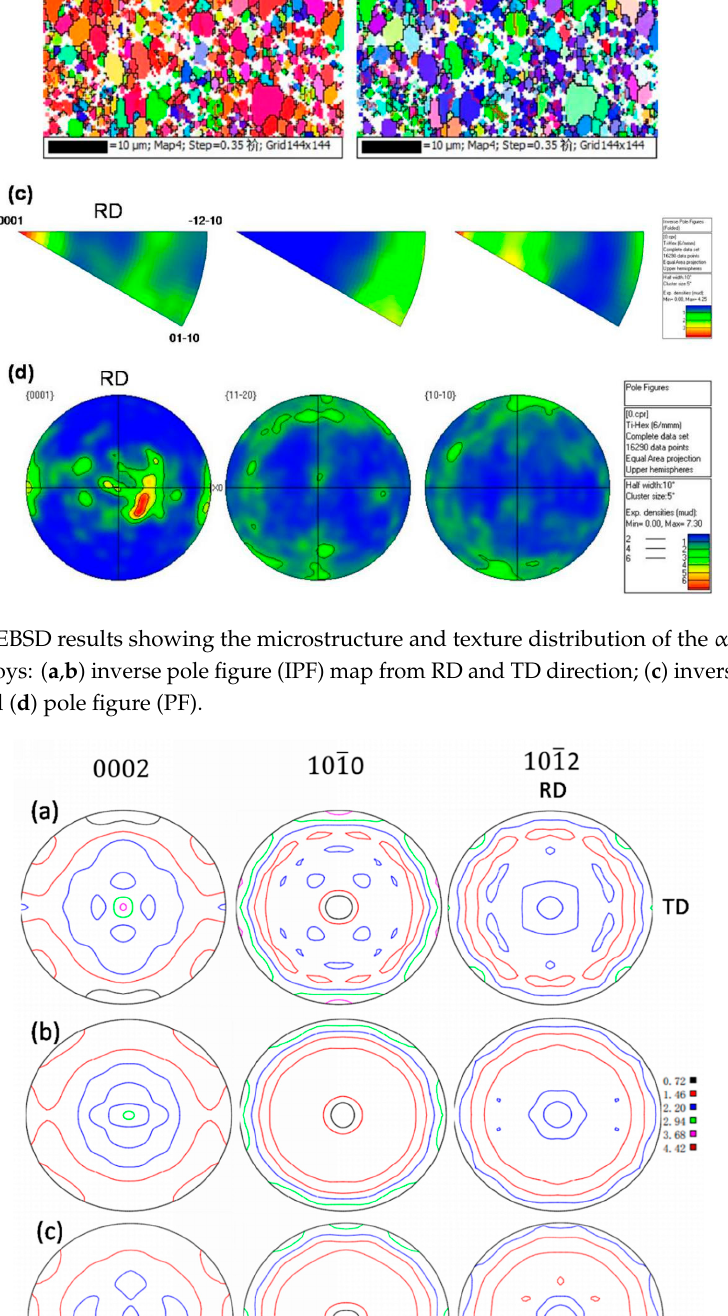
Figure 8. Pole diagram of different microstructure: ( a ) as-received Ti6Al4V alloy; ( b ) 920 °C × 1 h, AC solid solution treatment; and ( c ) 940 °C ×1 h, AC solid solution treatment.